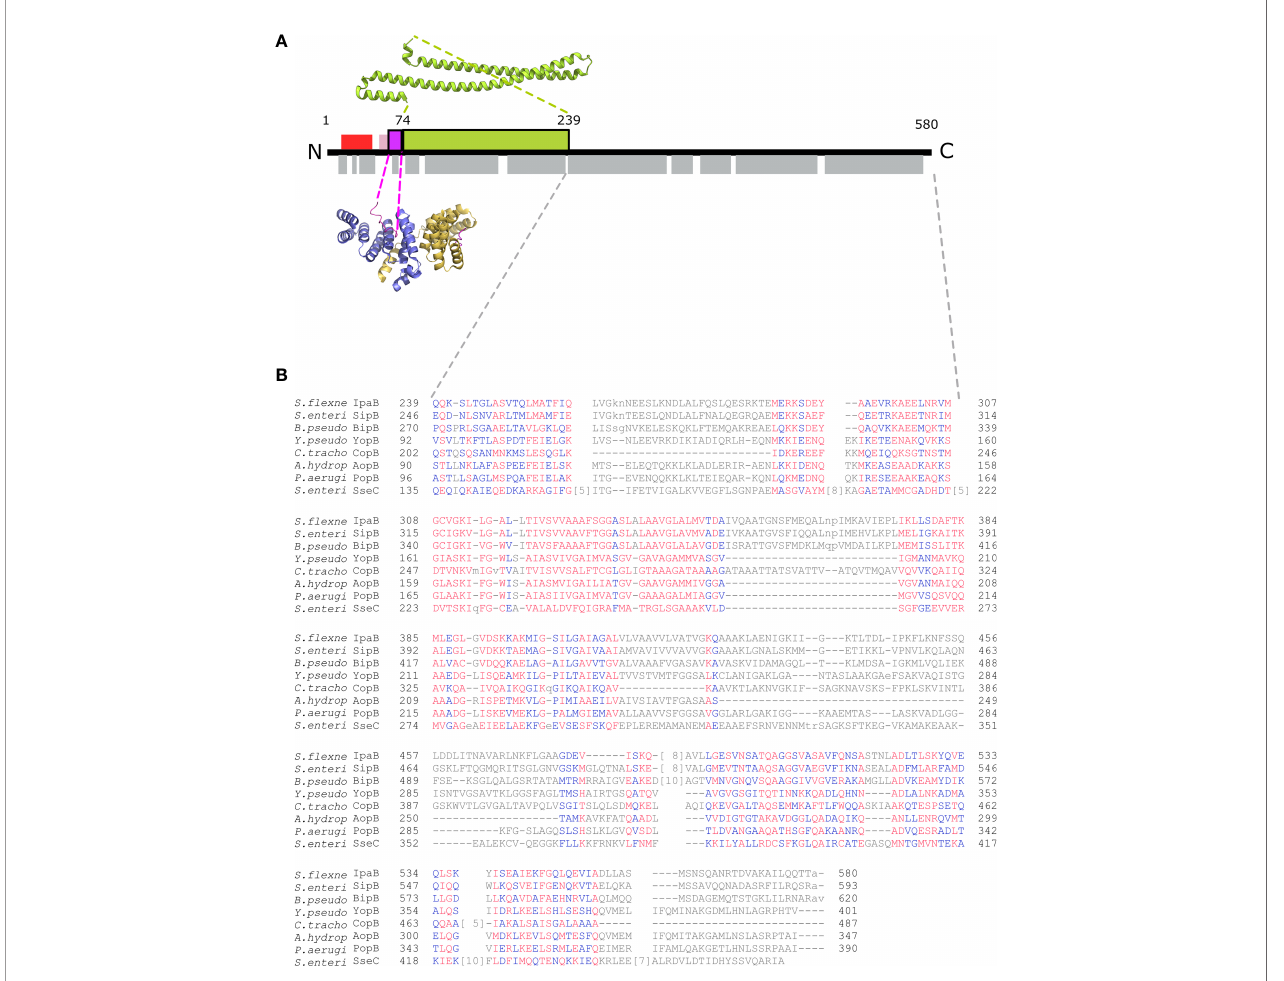
FIGURE 1 | IpgC/IpaB available structural information. (A) A schematic representation of the IpaB full-length protein and the available structural information. The long coiled-coil domain of IpaB (green rectangle, residues 74 - 239) is the only known domain in atomic resolution along with the Chaperone Binding Domain (CBD, magenta rectangle, residues 60-72). The CBD domain was found in extended conformation interacting with the major groove of one IpgC molecule (cartoon representation, blue monomer). See text for details. Other segments of IpaB were proposed as being implicated in the interaction with IpgC: a second CBD (red rectangle) at the N-terminal of IpaB; and an extension of the fi rst CBD (pink rectangle). Grey rectangles on bottom of IpaB sequence represent predicted a -helices. (B) Constraint-based Multiple Alignment, COBALT (Papadopoulos and Agarwala, 2007). Part of the alignment, focusing on the C-terminal part of major translocators from T3S systems of different origin, is presented. Multiple sequence alignment columns with no gaps are colored. Higher conserved columns in red, less conserved ones in blue and non-conserved in grey. Accession numbers for the protein sequences used are provided in Materials and Methods section Modeling of the IpgC/ IpaB Complex